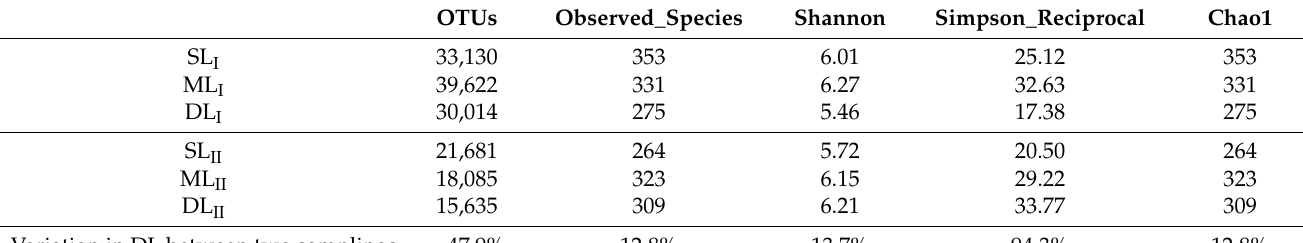
Table 3. Characteristics of soil bacterial richness and diversity indices in different soil samples.